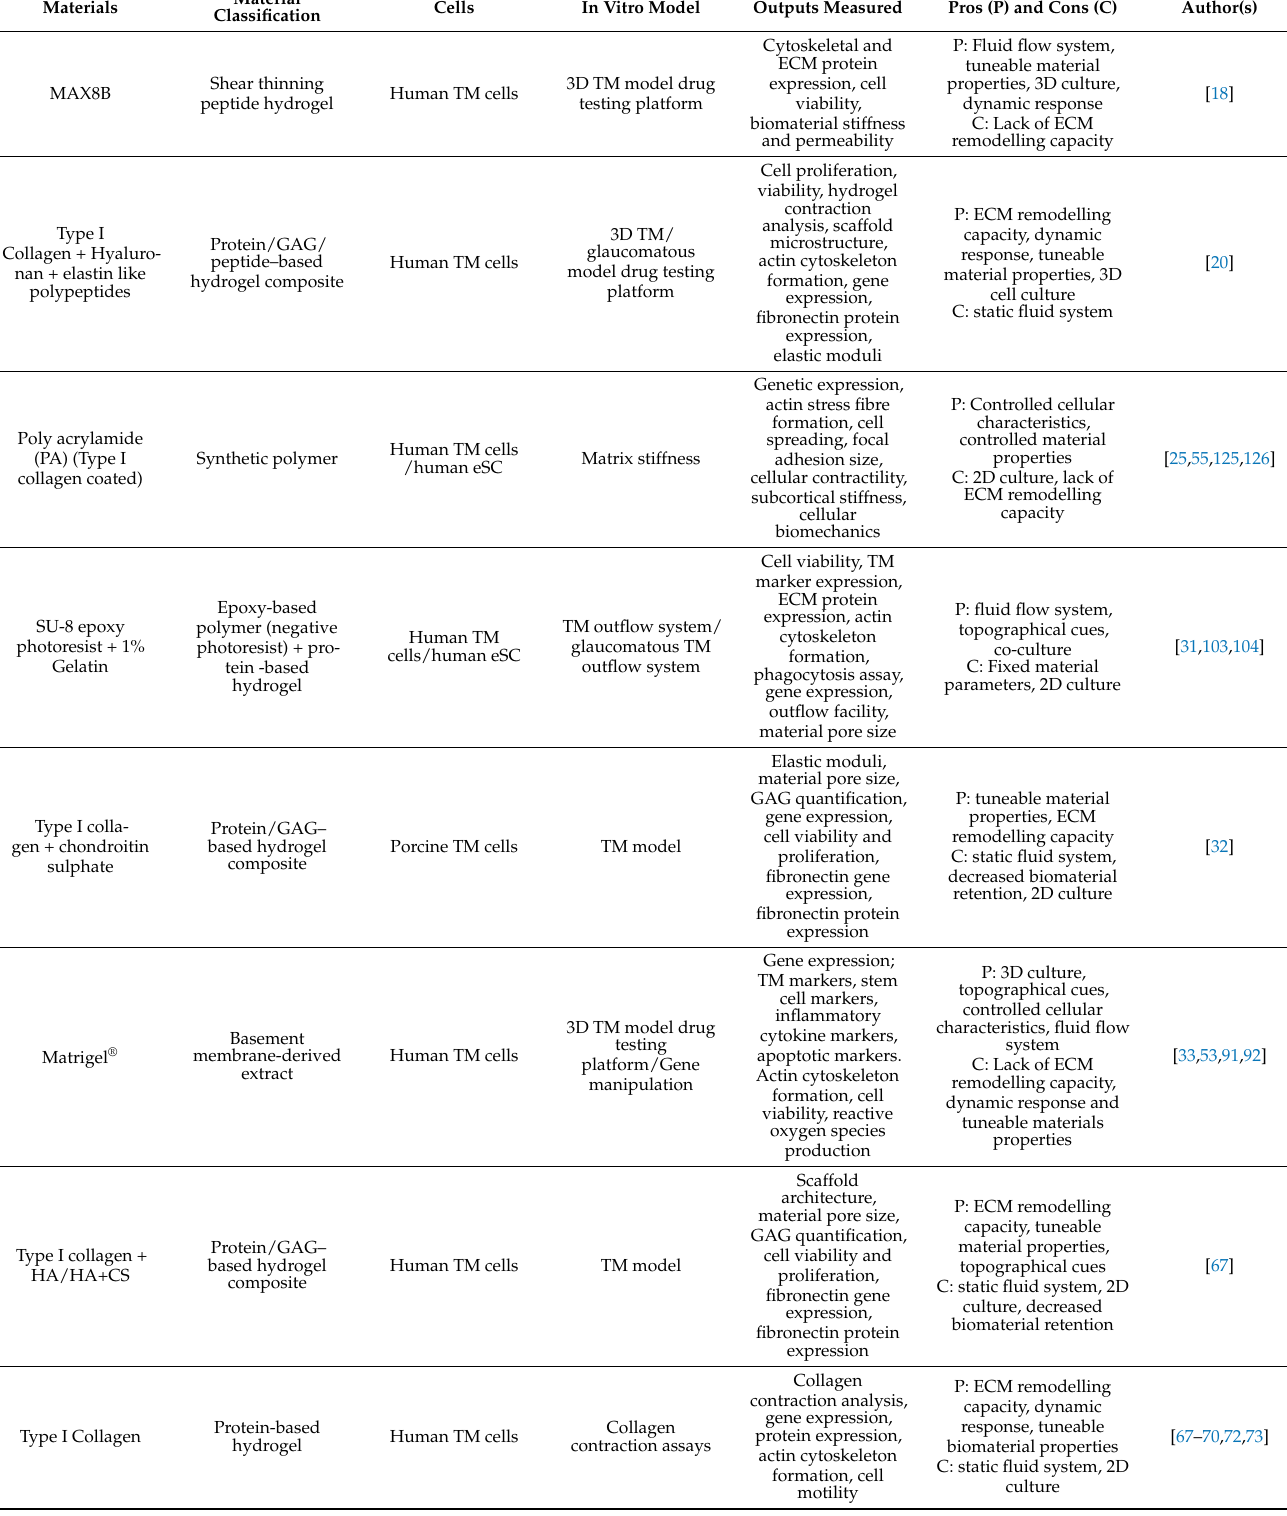
Table 1. Biomaterial applications for in vitro TM and eSC